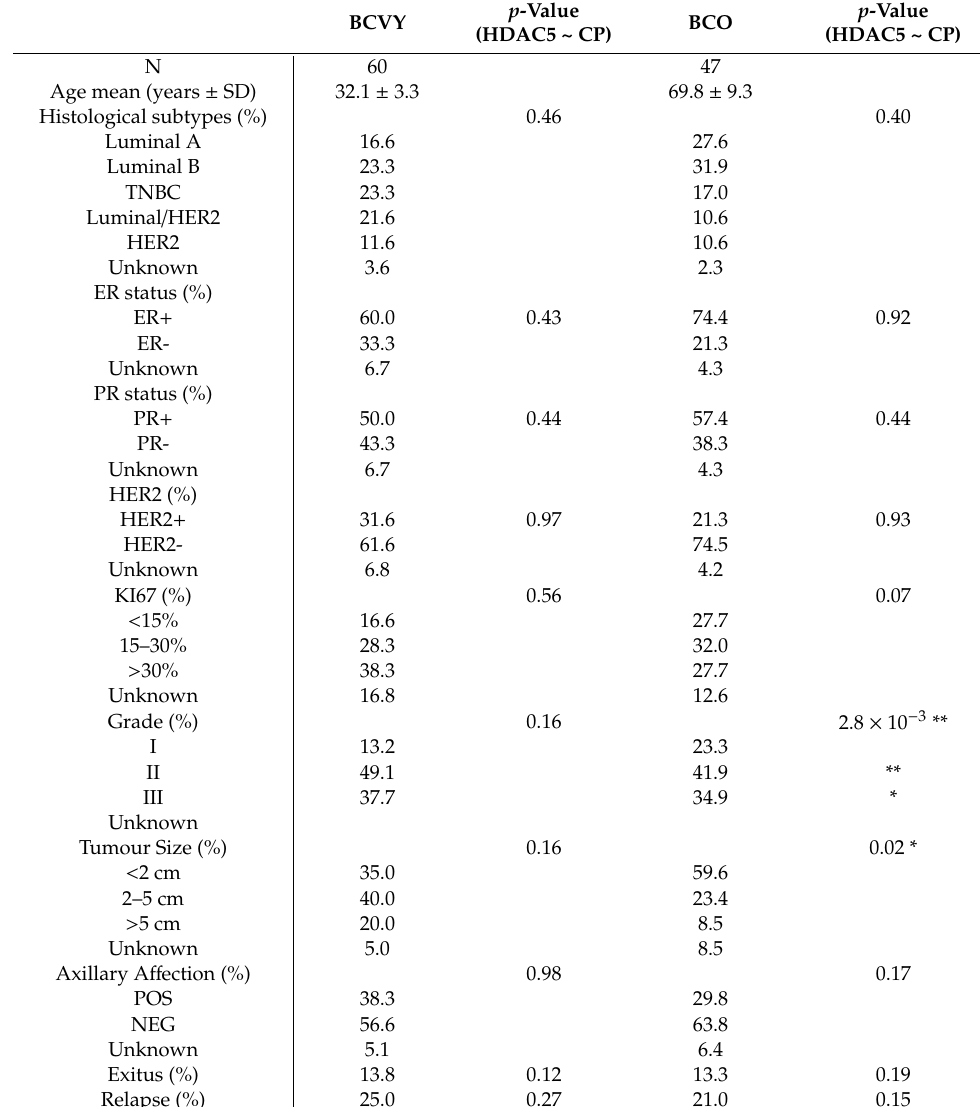
Table 1. Clinicopathological information of breast cancer (BC) samples and statistical results from the study of HDAC5 expression vs. clinicopathological features by age